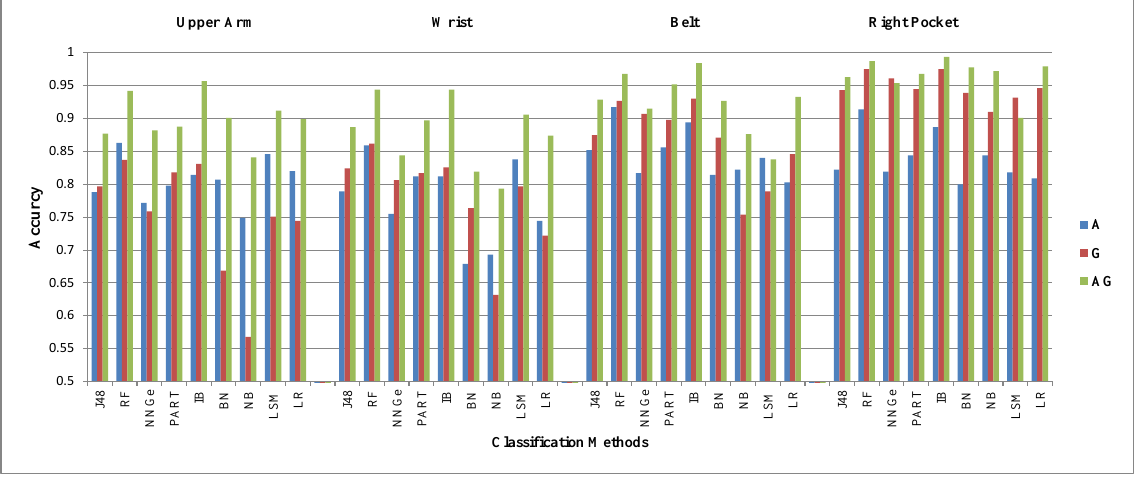
Figure 3. Recognition performance for the walking upstairs activity using